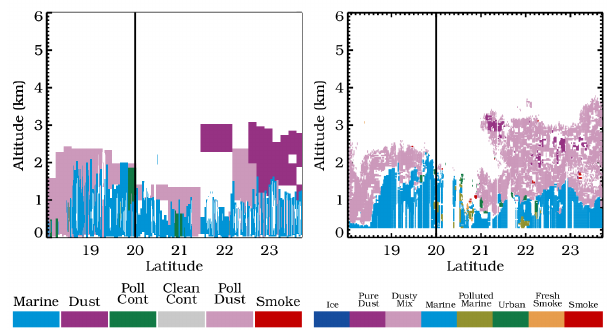
Fig. 5. Aerosol classification masks from CALIOP (left) and HSRL-1 (right) for a nighttime scene in the Caribbean Sea on 24 August 2010 (same as Fig. 1). Saharan dust which was advected across the Atlantic Ocean lies above the marine boundary layer. The CALIPSO satellite transited this scene in 1.7min. The transit time for the B200 with HSRL aboard was 101min. The point of closest approach is indicated by a vertical